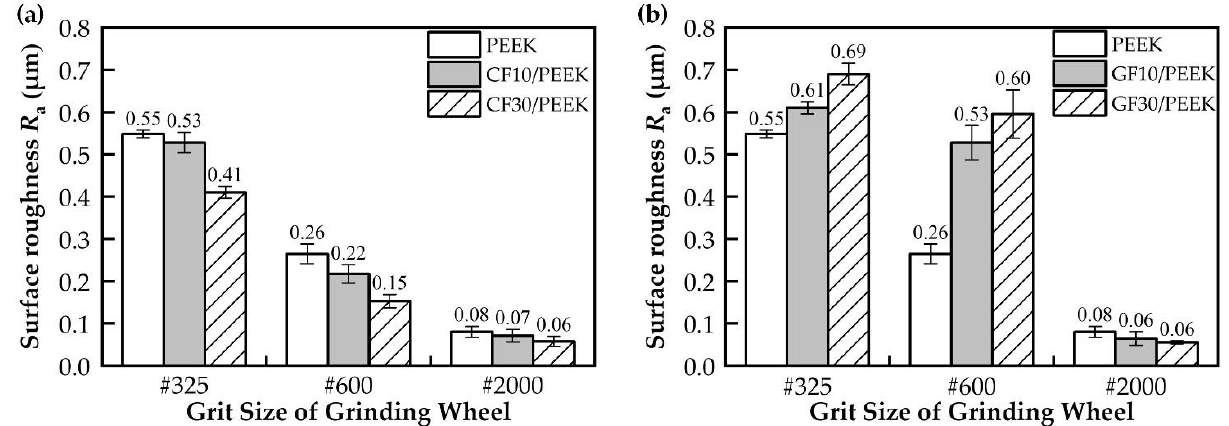
Figure 3. Effect of different grinding parameters on the surface roughness of PEEK: ( a ) effect of grinding wheel speed; ( b ) effect of wheel feed rate; ( c ) effect of rotary table speed.